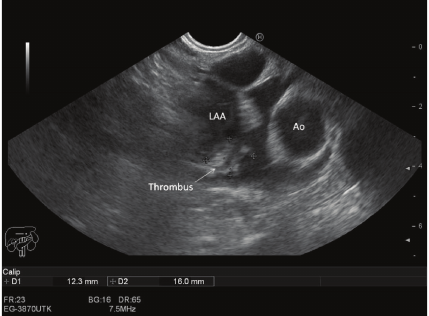
Figure 2: Thrombus detection in the left atrial appendage using endoscopic ultrasound technique. LAA: left atrial appendage; Ao: aortic